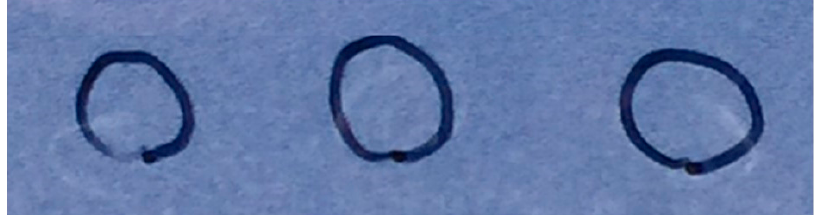
Figure 6. Photograph of three 10 µ L drops of 50 ng / mL fentanyl dried on part of a glass slide. Figure 6. Photograph of three 10 µL drops of 50 ng/mL fentanyl dried on part of a glass slide. This Figure 6. Photograph of three 10 µL drops of 50 ng/mL fentanyl dried on part of a glass slide. This This concentration corresponds to 500 pg. The samples, deposited on the opposite side of the ~5 mm concentration corresponds to 500 pg. The samples, deposited on the opposite side of the ~5 mm concentration corresponds to 500 pg. The samples, deposited on the opposite side of the ~5 mm Figure 6. Photograph of three 10 µL drops of 50 ng/mL fentanyl dried on part of a glass slide. This diameter black marked rings, migrated during evaporation, forming nearly invisible white diameter black marked rings, migrated during evaporation, forming nearly invisible white rings. diameter black marked rings, migrated during evaporation, forming nearly invisible white rings. concentration corresponds to 500 pg. The samples, deposited on the opposite side of the ~5 mm diameter black marked rings, migrated during evaporation, forming nearly invisible white rings.